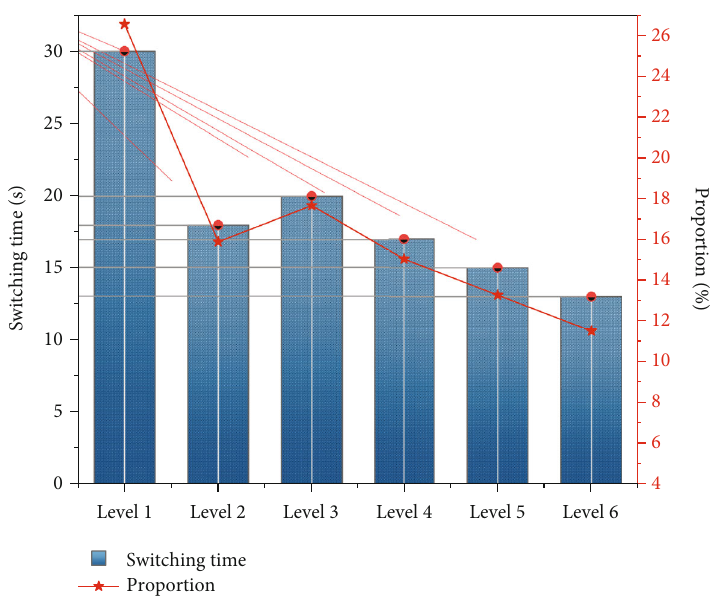
Figure 3: Students ’ switching time curve between AR environment and real